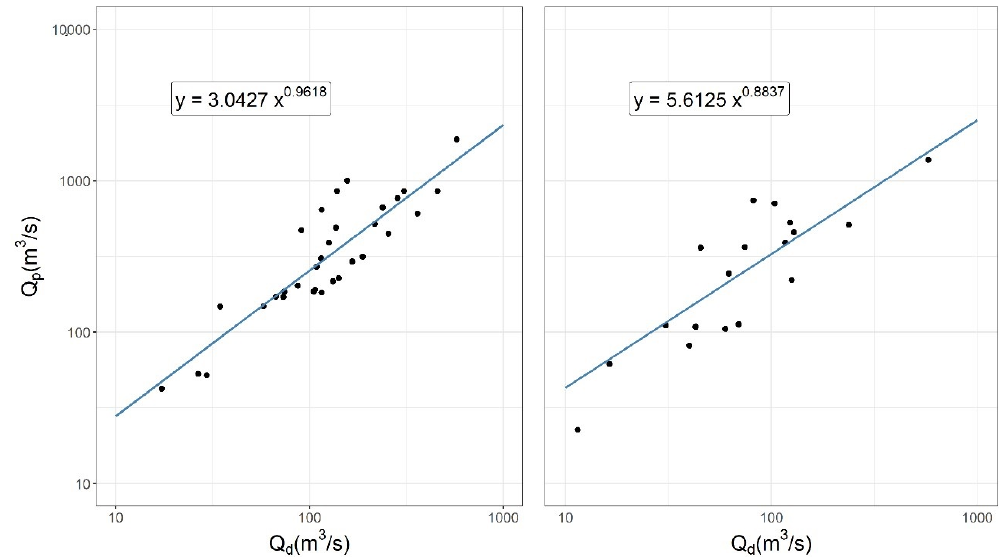
Figure 7. Potential regression between daily (Q d ) and simulated peak discharges (Q p ) at palaeoflood sites: Left, Rambla de la Viuda NS site; Right, Montlleó NS site.